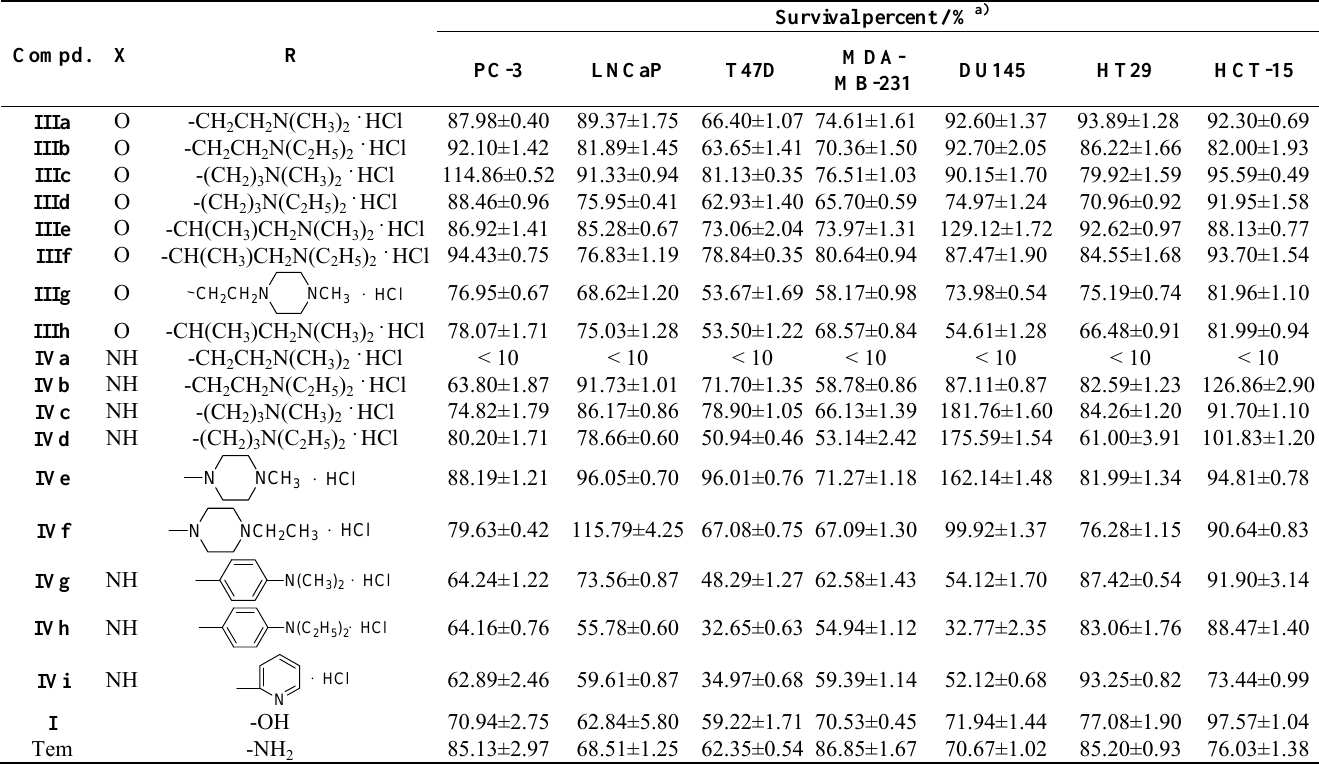
Table 1. The substituents and cytotoxicity of the title compounds IIIa - IVi . Compd. X